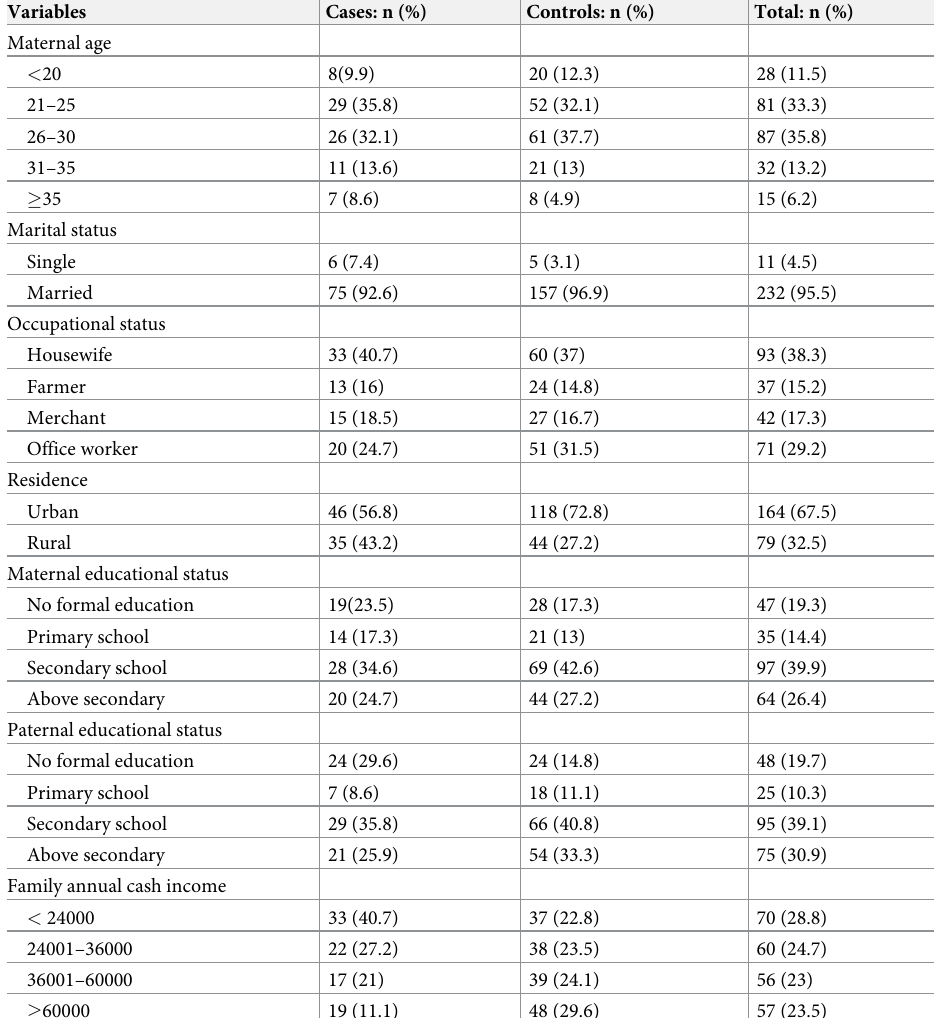
Table 1. Socio-demographic characteristics of mothers who gave birth in North Shoa Zone Hospitals, Amhara Region, Ethiopia,